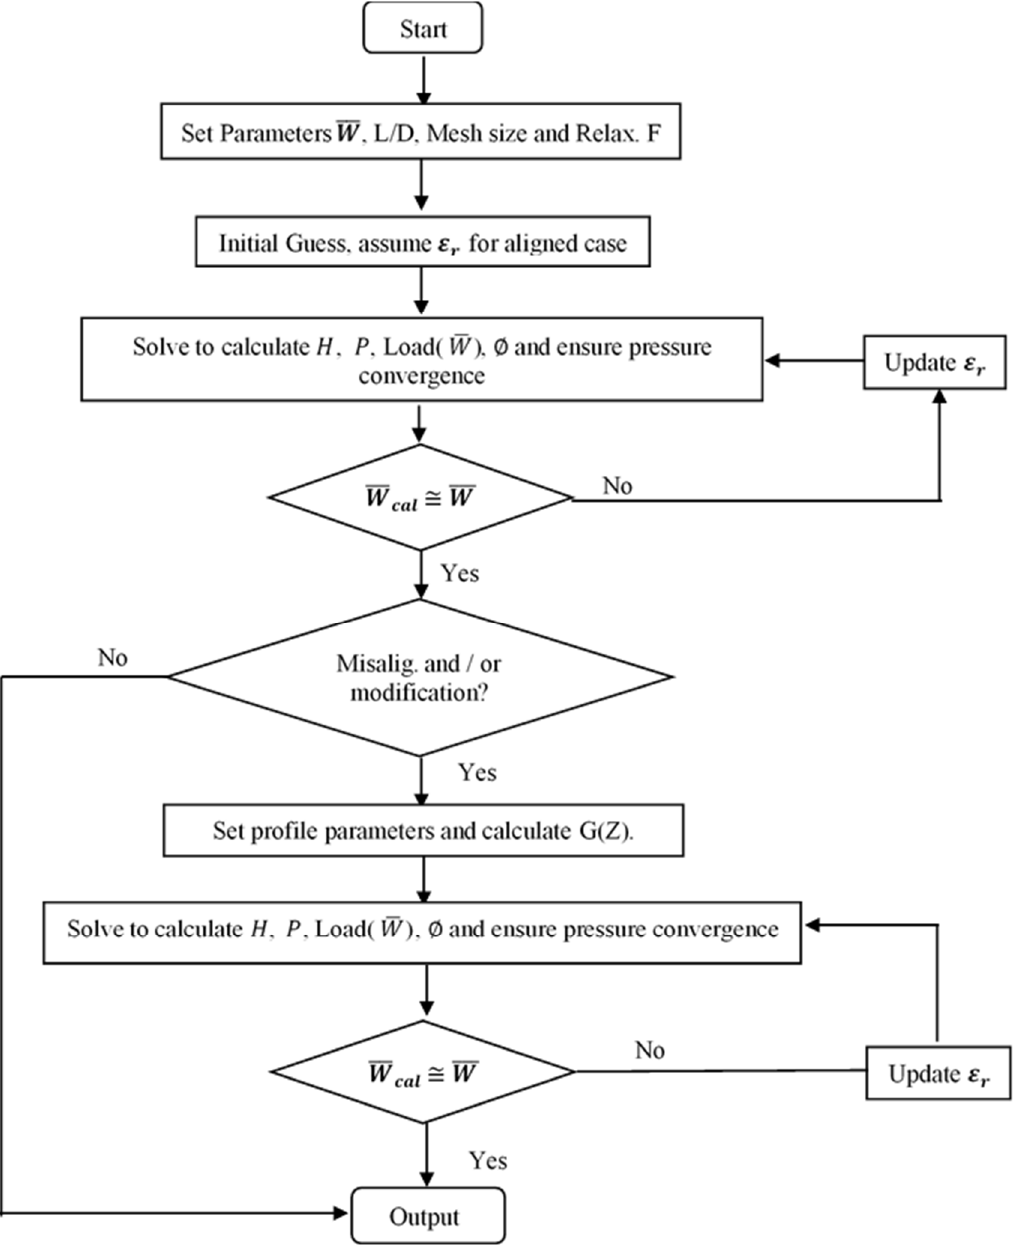
Figure 4. Flow chart for the solution procedure.